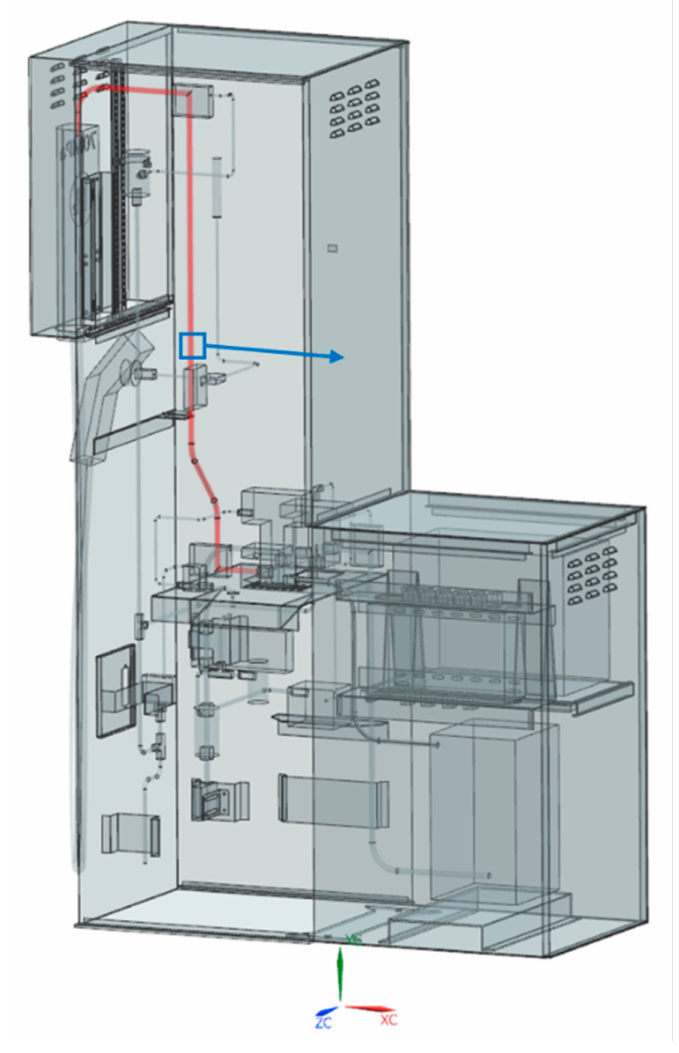
Figure 1. The geometry of the hydrogen dispenser and the leaking position on the main tube. The leaking positions of the dispenser are more likely to locate on the connections between the tubes and the joints. Hence, it is assumed that the leaking position is